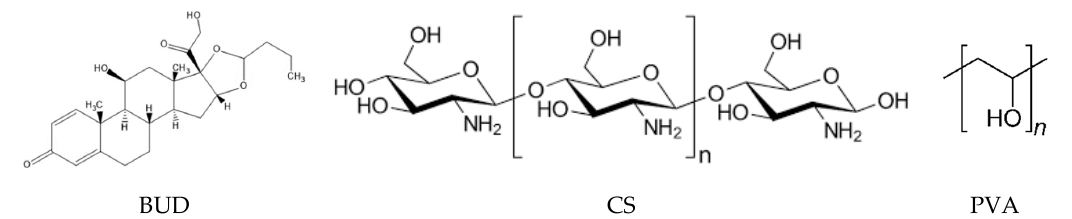
Figure 1. Molecular structures of Budesonide (BUD), chitosan and PVA.